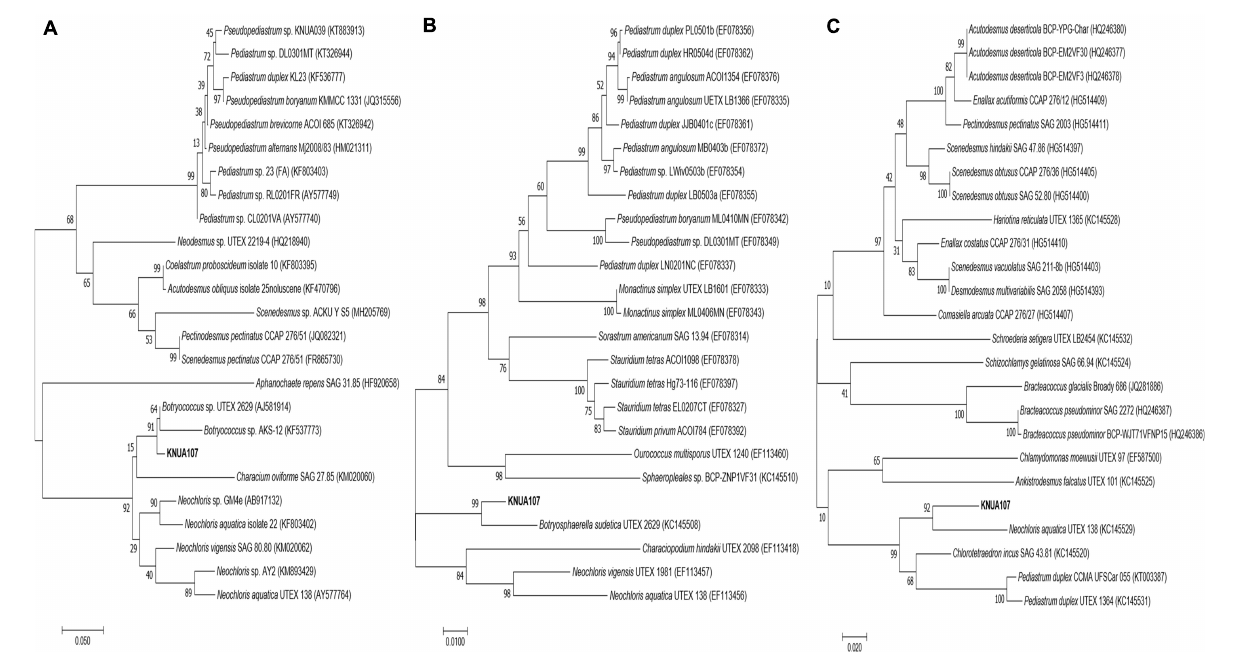
FIGURE 2 | Molecular phylogenetic analysis of B. sudetica KNUA107 according to the Maximum Likelihood (ML) tree. Numbers at the nodes indicate bootstrap probabilities of ML analyses (1,000 replicates). Three marker genes were used for the analysis: the ITS (internal transcribed spacer) region (A) , the rbc L (large unit ribulose bisphosphate carboxylase) region (B) , and the tuf A (elongation factor Tu gene) region (C) .